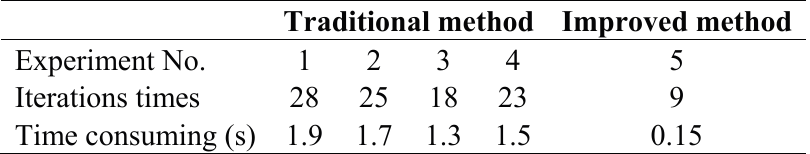
Table 2. Comparison of the different clustering